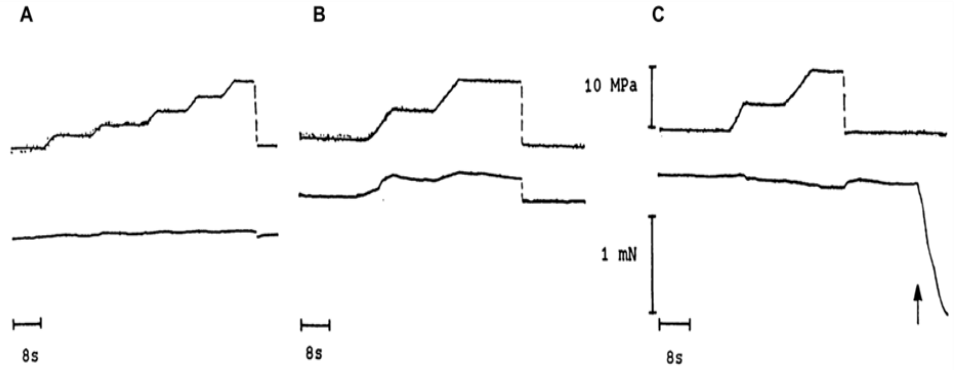
Figure 3. Tension records (lower trace in each) from a muscle fibre bundle (5 fibres, cross-section of 120 um and length of 4 mm) exposed to different pressures (upper trace in each). In each frame, the position of the horizontal time bar represents zero tension. ( A ) in relaxed state, ( B ) in rigour state, and ( C ) in maximally Ca-activated state — bundle was relaxed at the upward arrow, by exposing to relaxing solution (-no Ca). (Adapted from Ranatunga et al., 1991, [8]).